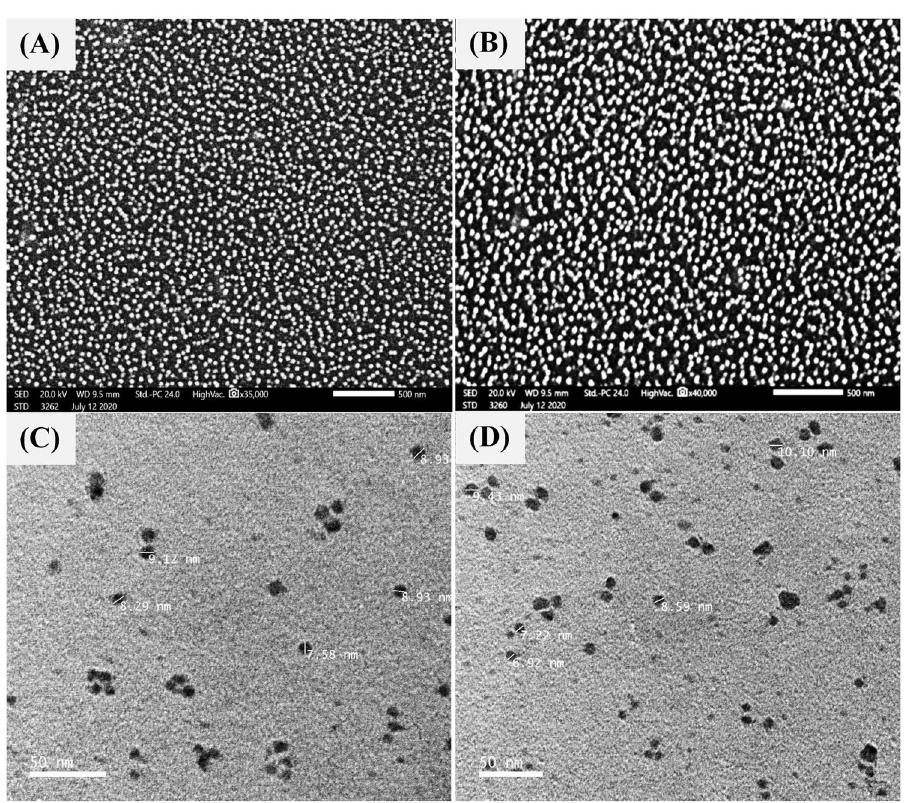
Figure 4. ( A,B ) SEM micrographs, ( C,D ) TEM micrograph of chitosan nanoparticles biosynthesised using Eucalyptus globulus Labill leaves